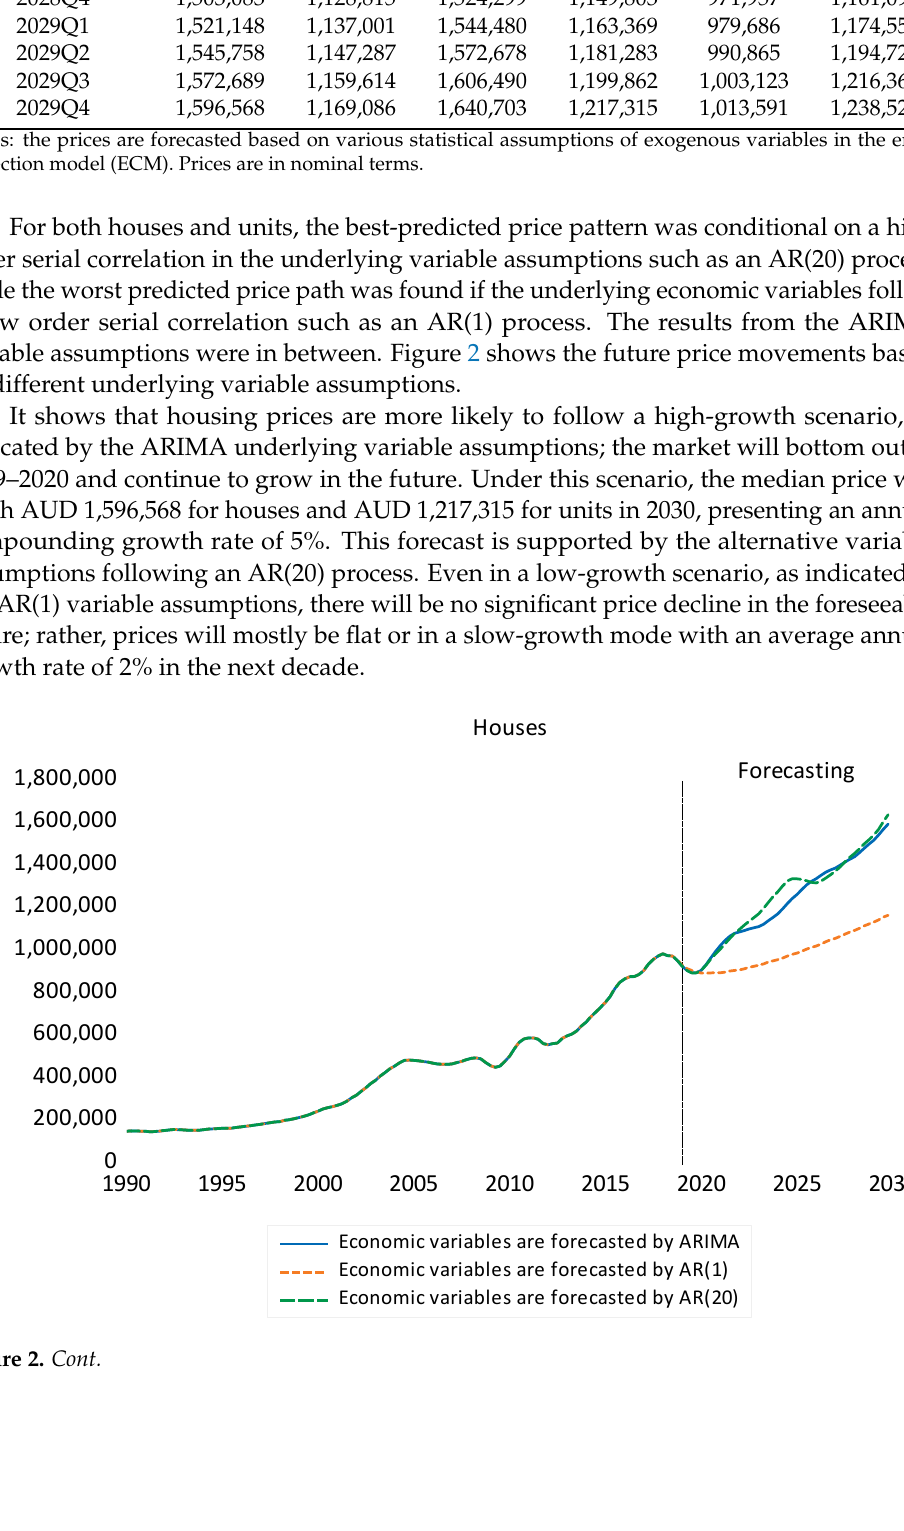
Figure 2. Forecasted Median Prices, 2019Q1–2029Q4. 5.4. Robustness Check 5.4.1. Unconditional Forecast The forecasting performance of the developed ECM model depends on the forecast- ing of underlying economic factors. This raises some concerns about the usefulness of the proposed ECM model. Alternatively, we used the unconditional forecast of the standard AR(1) process and ECM model without other economic factors to validate the results. The advantage of using an AR(1) process for house price forecasting is that it is simple and does not require any other variables in the modeling. As the standard ECM model only depends on prices, rents, and interest rates, there is no need to forecast other economic variables in this situation. Using the data from 2004 to 2013, we developed the standard